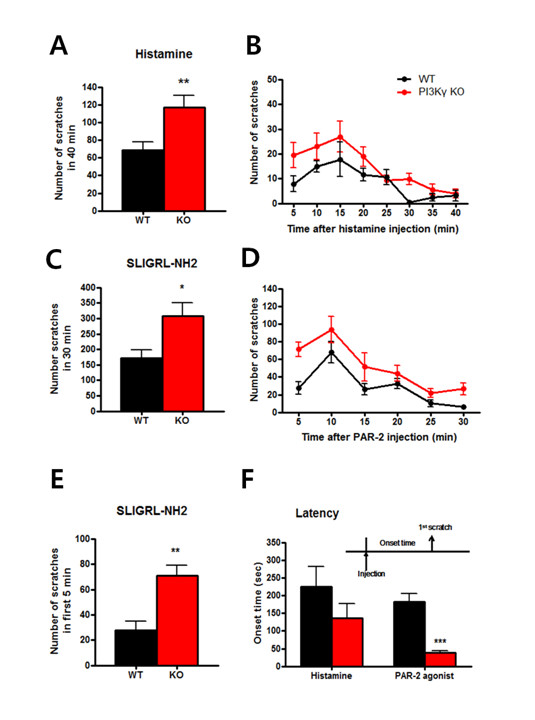
Histamine and PAR-2-induced hyper scratching in PI3Kγ deficient mice. (A and B) The total number of scratches that occurred over a 40-minute time period after histamine injection were counted. PI3Kγ KO exhibited enhanced scratching compared to WT littermates. (C and D) PAR-2 agonist induced itch was recorded; scratches were counted for 30 minutes. (E and F) The PI3Kγ KO scratched vigorously for the first 5 minutes; the latency until the first scratch was significantly earlier than in WT mice.